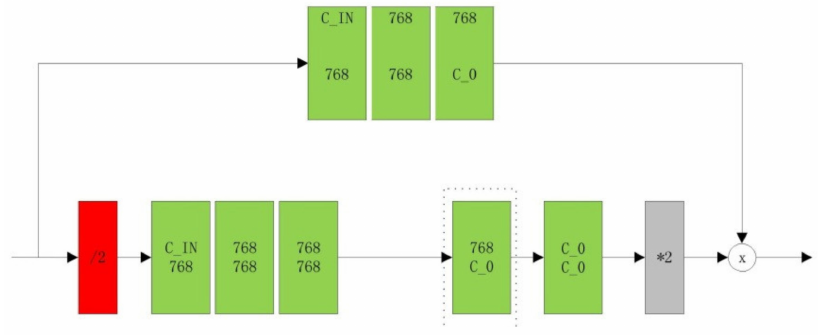
Figure 11. The structure of hourglass sub-networks.